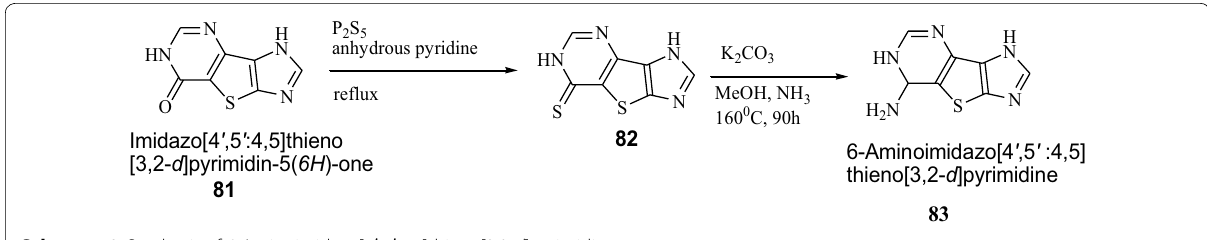
The % dead refers to the % of the dead tumor cells